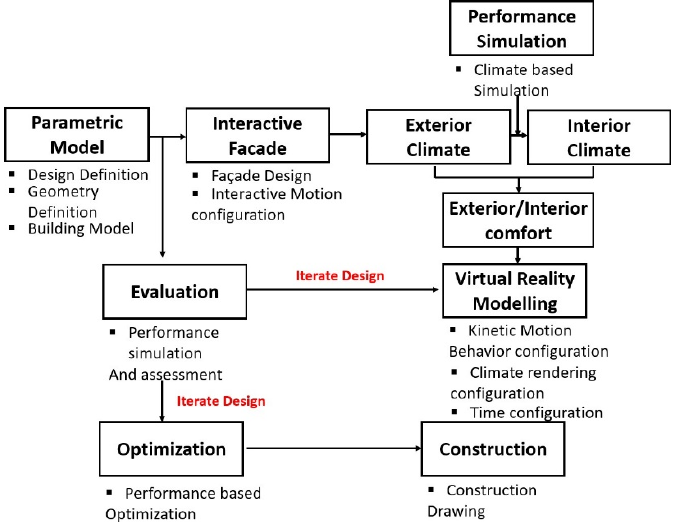
Figure 2. Proposed Design Process.